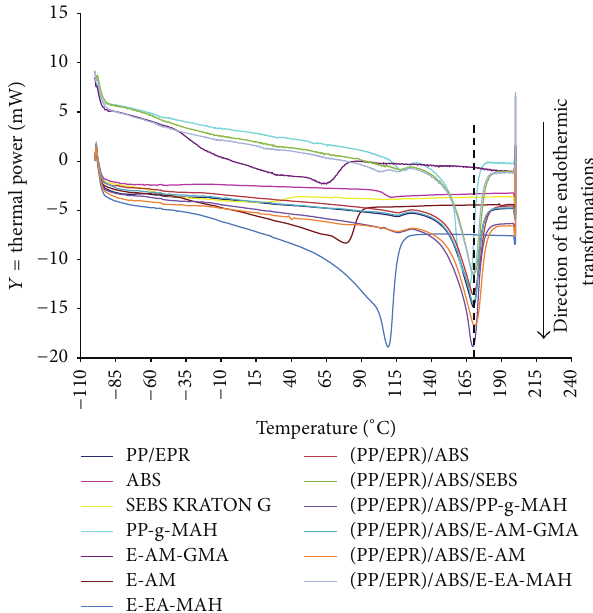
Figure 10: DSC curves in the direction of the endothermic transfor- mations of components and mixtures (PP/EPR)/ABS/compatibiliz- er (95)/5/5, for the second thermal cycle. For about 15 mg of sample. 1 graduation 𝑌 = 5 mW.